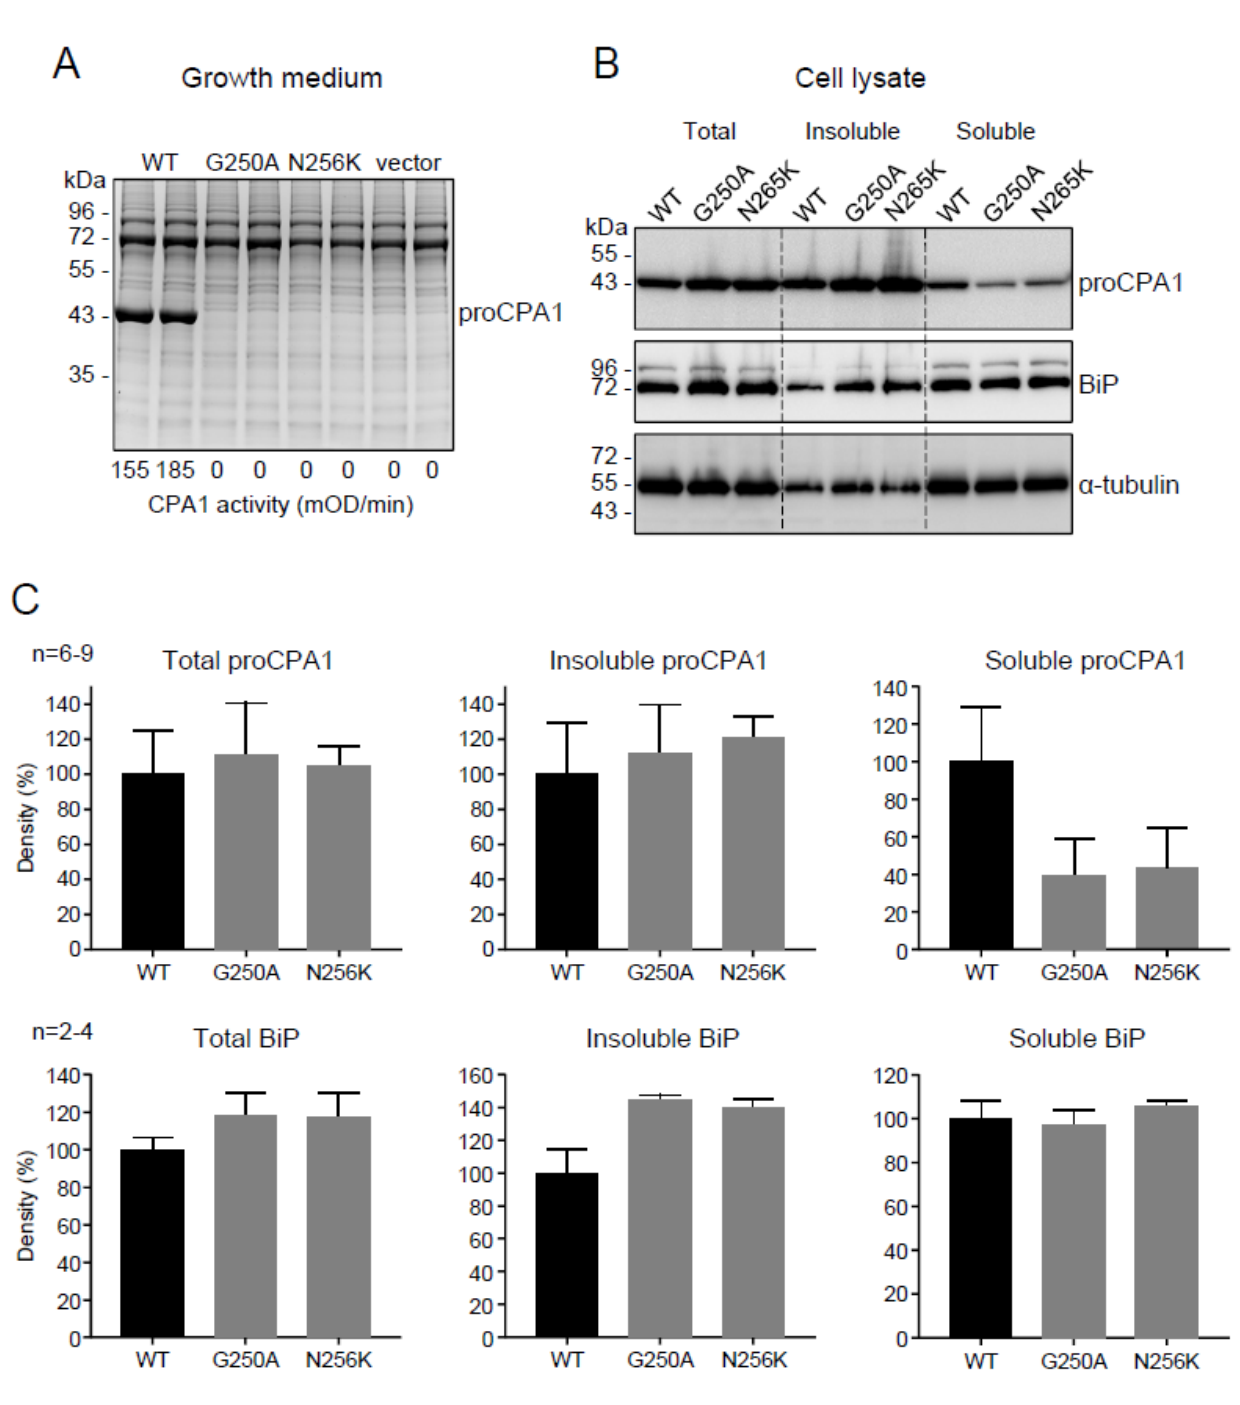
Figure 1. Effect of the p.G250A CPA1 variant on cellular secretion, enzyme activity, intracellular protein levels, solubility, and BiP protein levels in transfected HEK 293T cells. For comparison, wild-type CPA1 (WT), the reference pathogenic mutation p.N256K, and empty expression vector were studied. ( A ) Secretion of proCPA1 to the growth medium analyzed by SDS-PAGE and Coomassie Blue staining. CPA1 enzyme activity in the medium after activation of proCPA1 is indicated in milliOD/min units. ( B ) Protein levels of proCPA1, BiP, and α-tubulin in total cell lysates, and in the insoluble and soluble cellular fractions. Proteins were detected by Western blotting. ( C ) Densitometric evaluation of proCPA1 and BiP levels in total cell lysates, and in the insoluble and soluble cellular fractions.